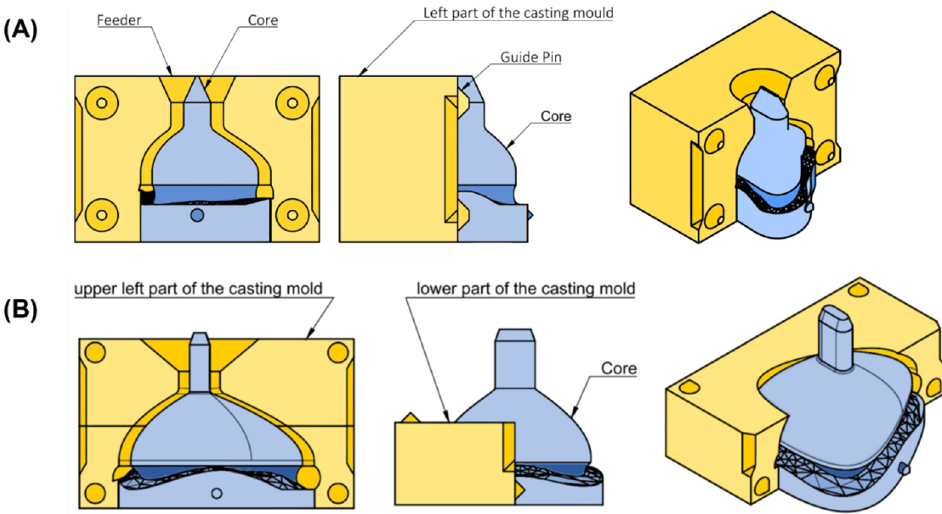
Figure 6. Technical drawing of casting mold for nasal and oronasal masks. ( A ) Isometric view (right), side view (middle) and front view (left) from casting mold for nasal mask; ( B ) Isometric view (right) with (left) and without (middle) upper left part from casting mold for oronasal mask.